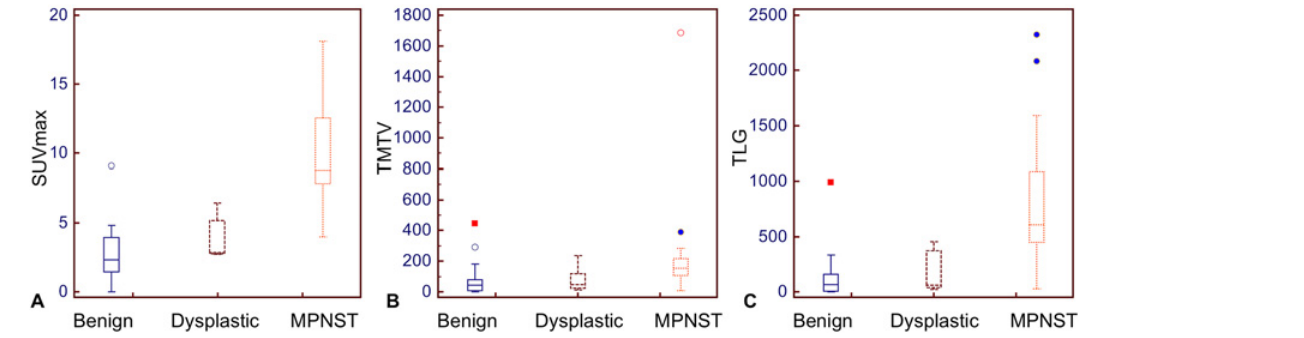
Fig 2. Box-plot repartition of SUV max (A), TMTV (B) and TLG (C) in the three histopathological groups of